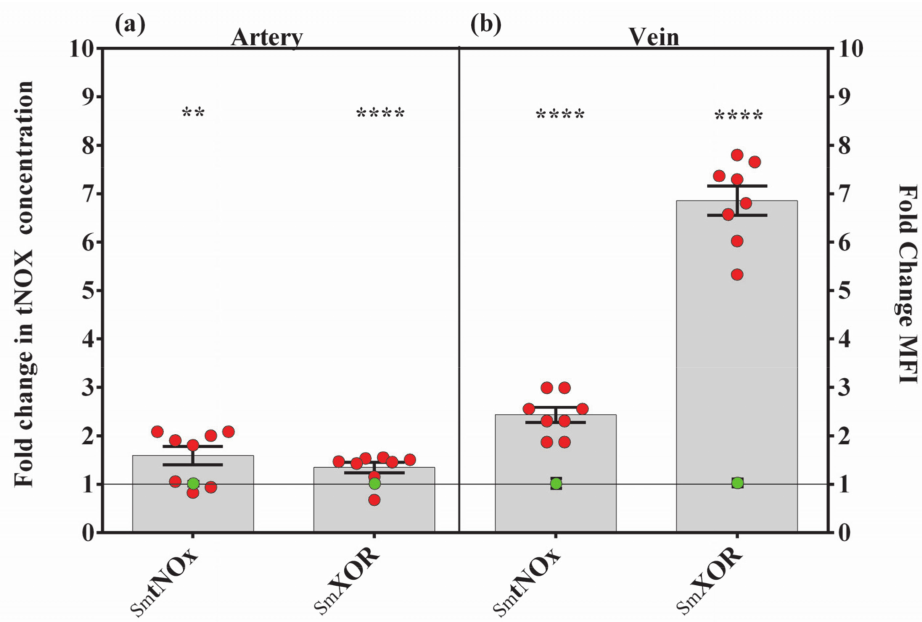
Figure 4. Changes in NOS-independent NO production in Sm-derived UC vessels. Bar graphs show the semiquantified results of xanthine oxidoreductase (XOR)-specific immunolabeling and the tNOx concentrations determined by a Griess microassay in Sm arteries ( a ) and in Sm veins ( b ). Red dots symbolize the overall MFI or tNOx concentration values from individual Sm samples, while green dots refer to the summarized data from the Ctrl group, applied as the baseline of compari- son (mean ± SEM). Sample numbers: CtrlXOR ( n = 44 artery and 83 vein ROI from 8 individual samples); SmXOR ( n = 33 artery and 19 vein ROI from 8 individual samples). In case of CtrltNOx ( n = 8 individual samples) and SmtNOx ( n = 8 individual samples) measurements carried out in triplicates. Statistics: unpaired t -test followed by Mann–Whitney test to compare ranks, ** p ≤ 0.01, **** p ≤